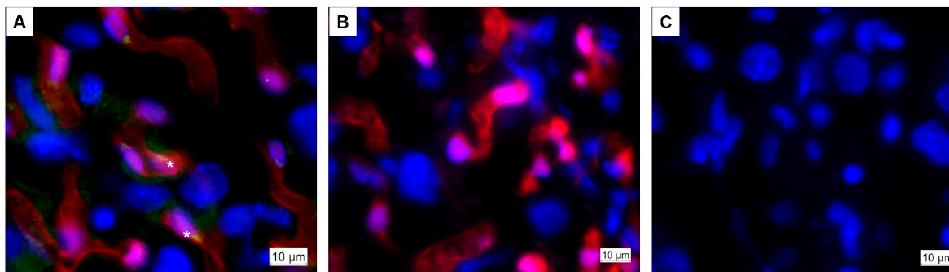
Figure 5 . Expression of Cdh5-Cre and Hand1 in the placental labyrinth at embryonic day 16.5. ( A ) Cdh5-Cre (red) is expressed in endothelial cells, overlapping with Hand1 protein expression (green). ( B ) Representative negative control for Hand1 immunofluorescence. ( C ) Representative image of tdTomato fluorescence in a Cdh5 Cre- placenta. Asterix indicates fetal capillary.